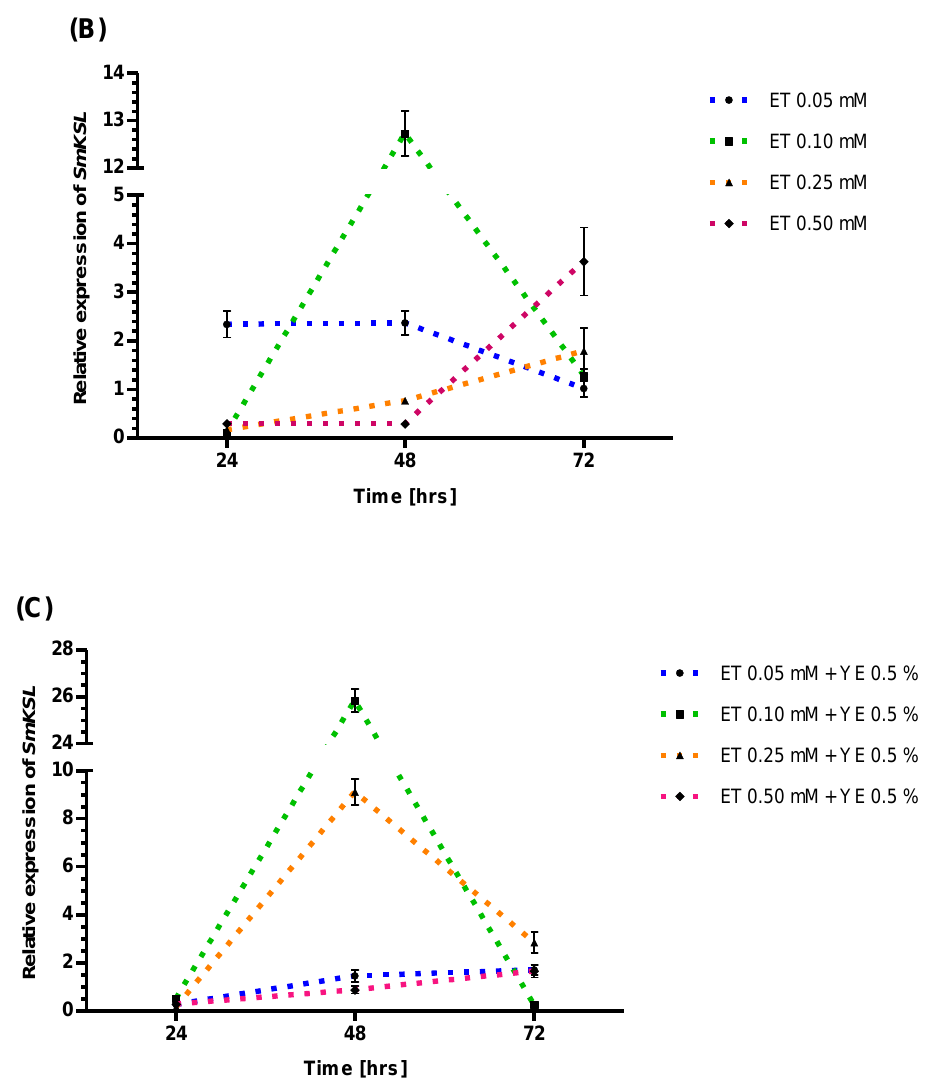
Figure 2. Temporal changes of SmKSL gene expression evaluated at 24, 48, and 72 h after treat- mentby 0.5, 2.0, 4.0% YE ( A ), 0.05, 0.10, 0.25, 0.50 mM ET ( B ), 0.5% YE plus 0.05, 0.10, 0.25, and 0.50 mM ET ( C ). Results presented as mean +/- standard